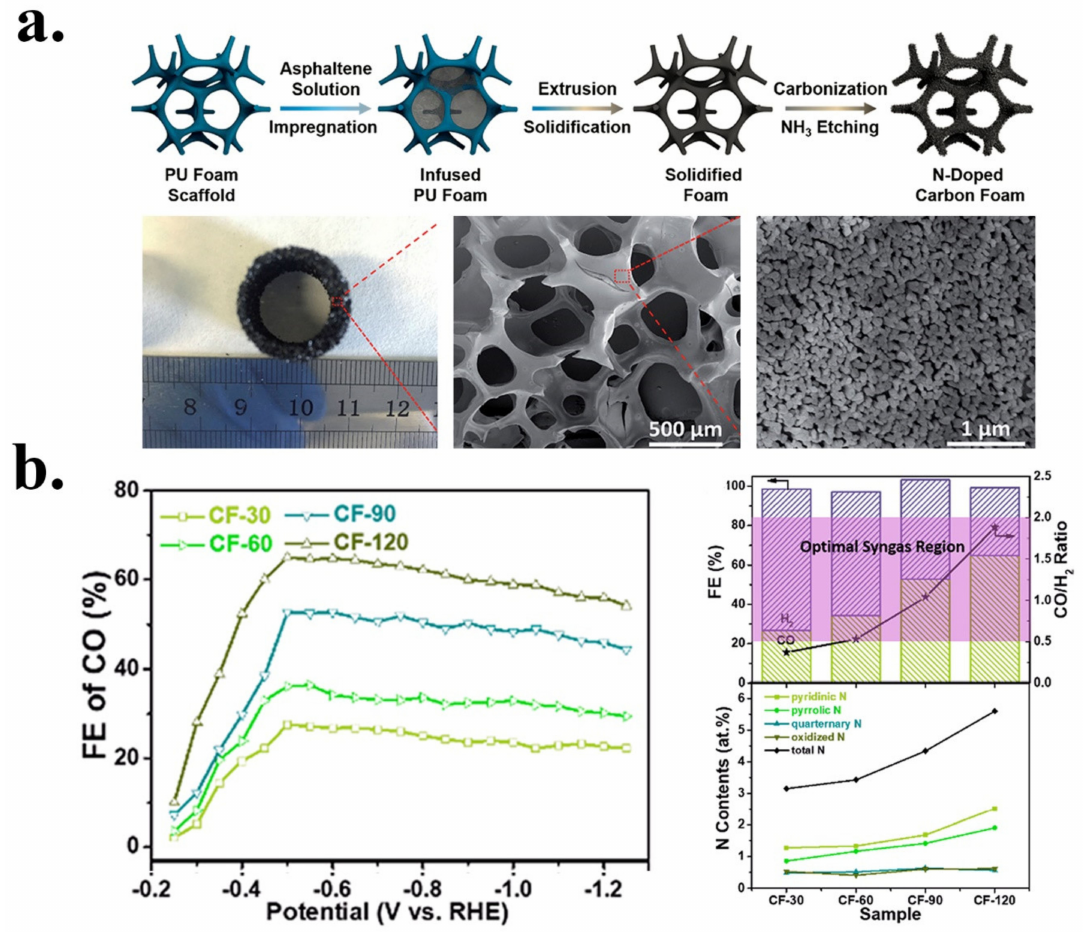
Figure 6. ( a ) Scheme of the synthesis, digital photograph, and SEM images of N-doped carbon foam (after 120 min of NH 3 etching). ( b ) Faradaic efficiencies for CO at different applied potentials (left) and Faradaic efficiencies and the corresponding proportions of syngas at − 0.6 V vs. RHE as a function of N content (right). Adapted from